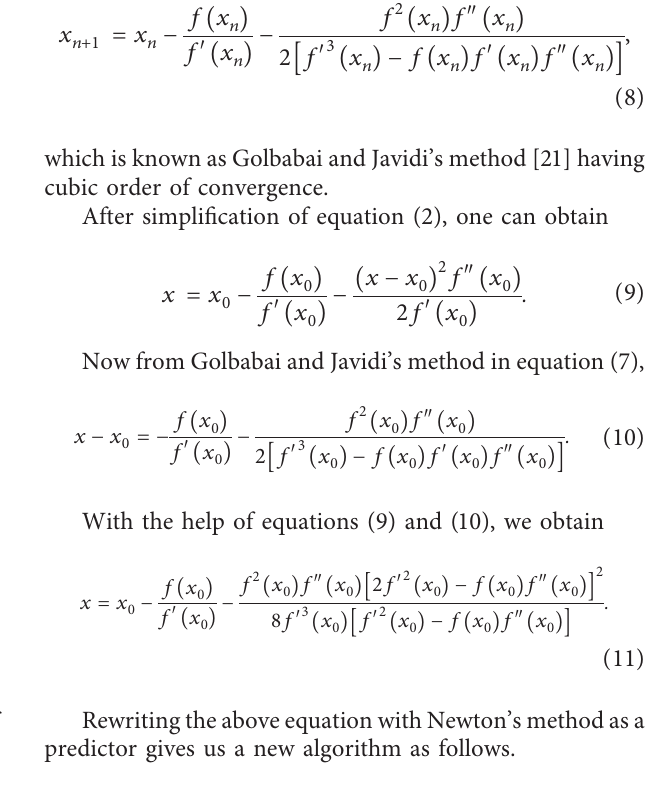
Algorithm 1. For a given x